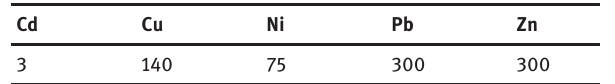
Table 3: The maximum total metal content (ppm) in agricultural soils recommended by European Union